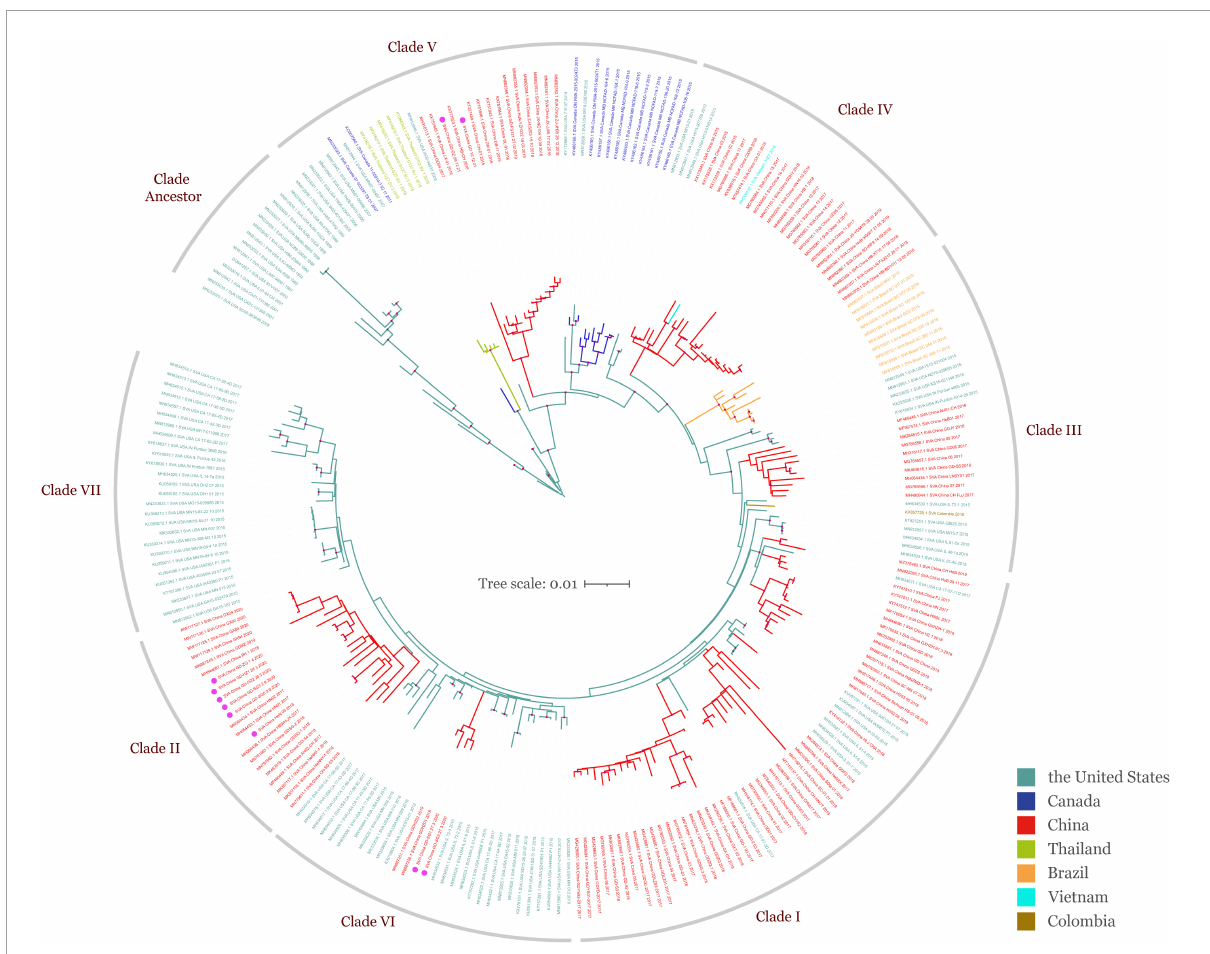
FIGURE1 Global ML phylogeny of all publicly available SVA strains and SVA isolated in our lab based on the ORF gene. The GTR + F + I + G4 nucleotide substitution model was used for phylogenetic tree construction. All SVA strains ( n = 250) from different countries are grouped by color and were clustered into eight clades including Clade Ancestor and Clade I–VII. The scale bar represents the number of substitutions per site along the branch in the tree topology. Light mauve dots on the tree topology indicate the bootstrap value of 100. Isolates obtained from field specimens are marked with magenta